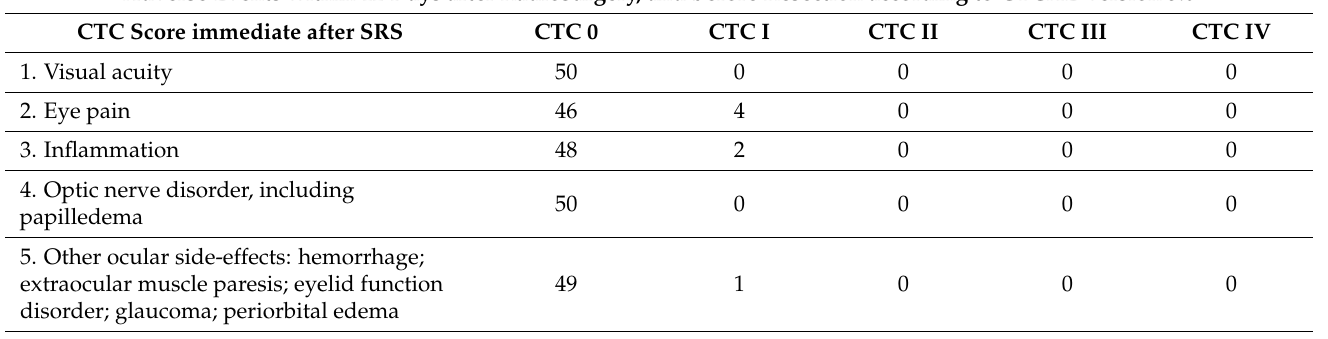
Table 2. Classification of outcome according to Common Terminology Criteria for Adverse Events